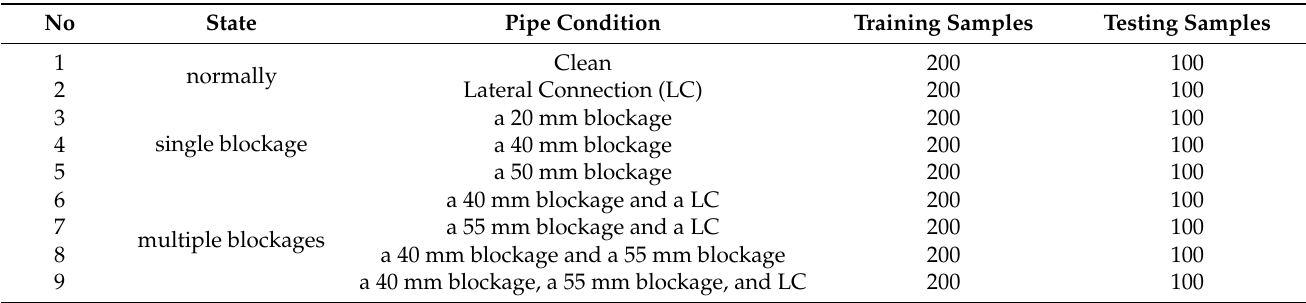
Table 1. Pipe conditions